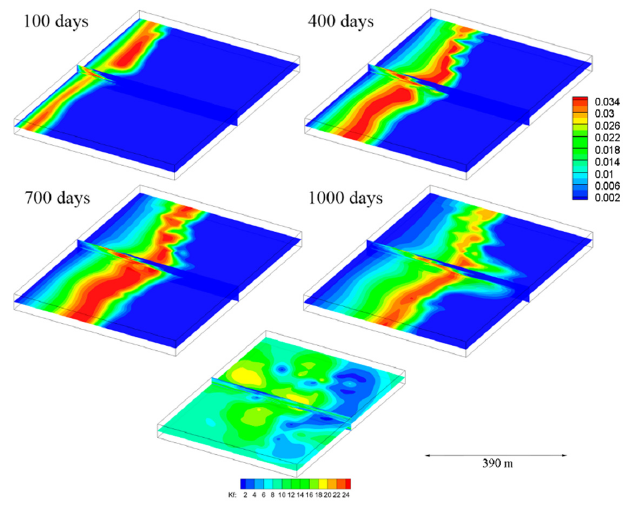
Figure 5. Deposit genesis over time through a heterogenous porous media.